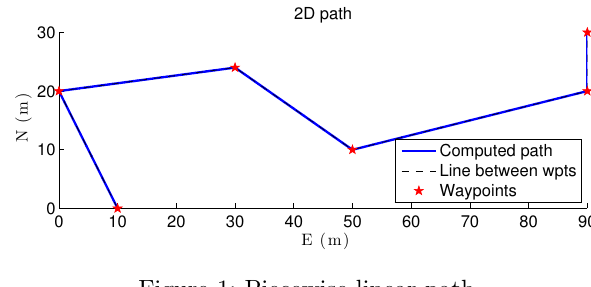
Figure 1: Piecewise linear path